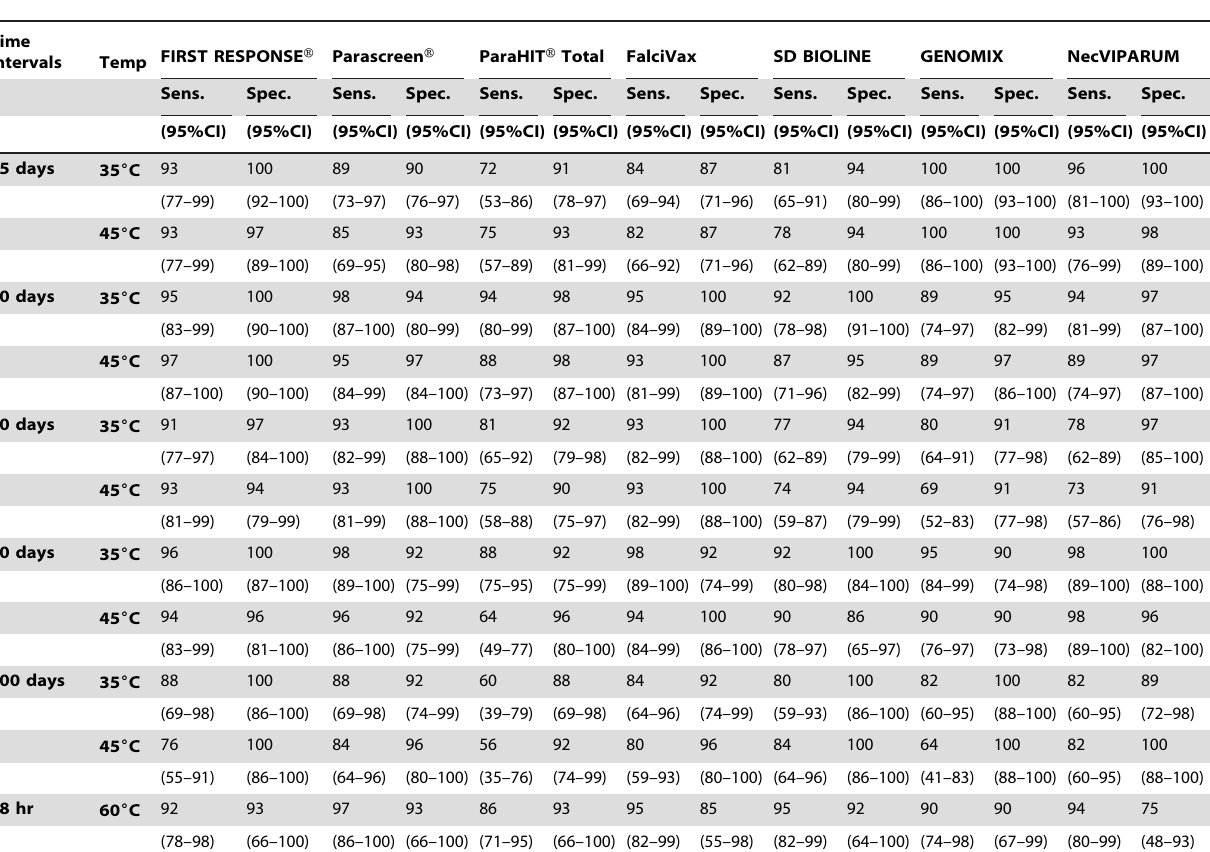
Table 3. Sensitivity of 7 different RDTs at 35 u C, 45 u C and 60 u C for P. falciparum against Room Temperature.